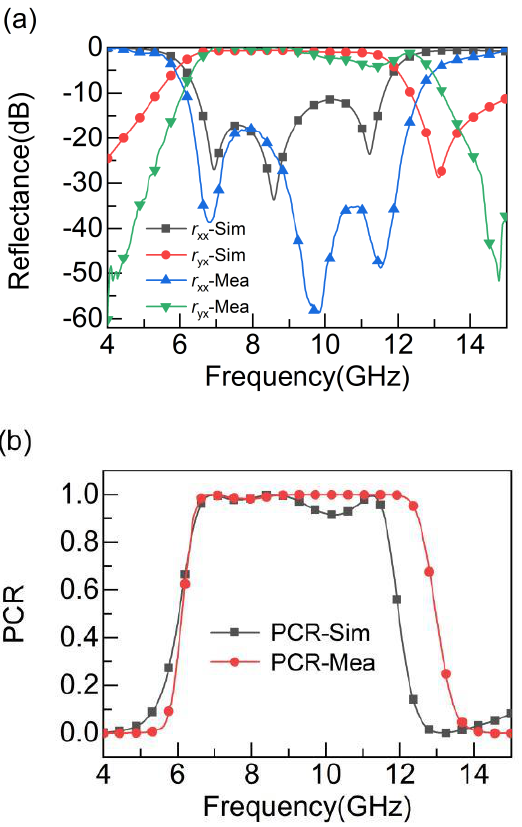
Figure 5. Simulated and measured results of x -polarized incidence. ( a ) Reflectance; ( b ) PCR.